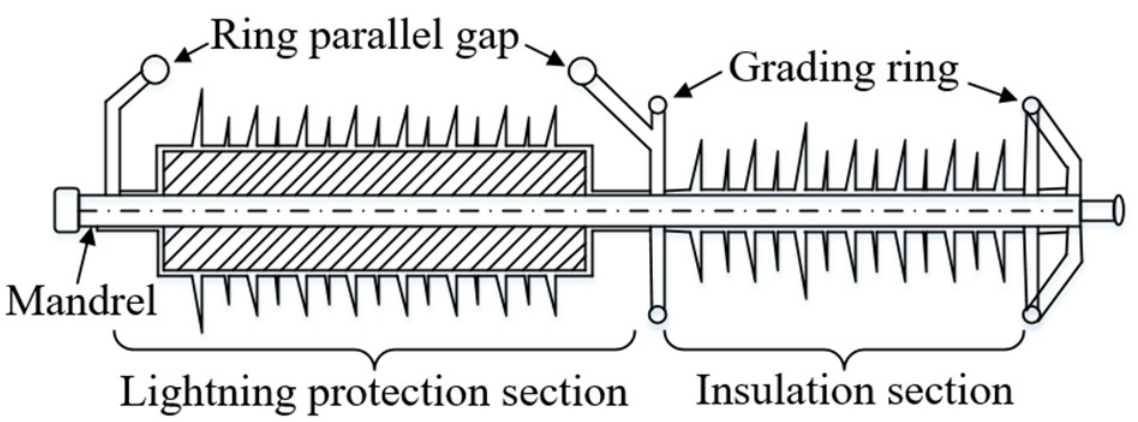
Figure 2. Structure diagram of anti-thunder and anti-icing composite insulator.